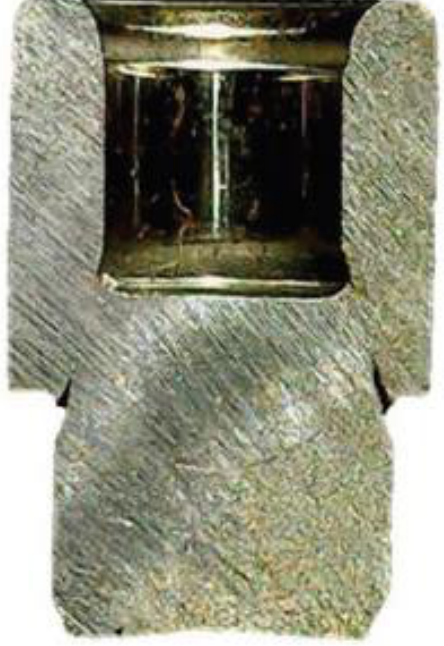
Figure 1. A crack defect of support pin by cold combined forward-backward extrusion (CFBE) [1].